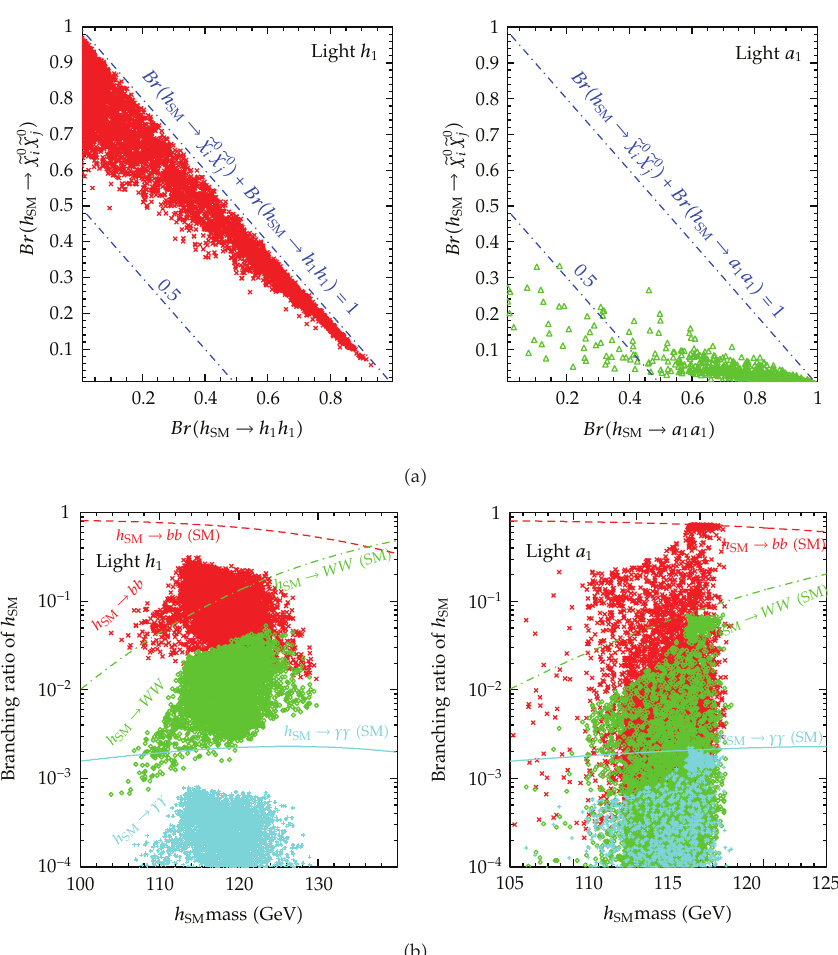
Figure 7: Same as Figure 6, but showing the decay branching ratios of the SM-like Higgs boson h SM . Here (cid:2) χ 0 (cid:3) denotes the total rates for all possible h B r (cid:2) h SM → (cid:2) χ 0 i j